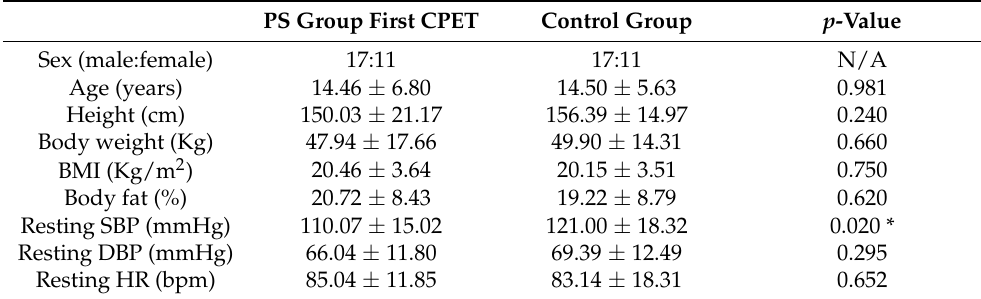
Table 2. Patient demographic characteristics.